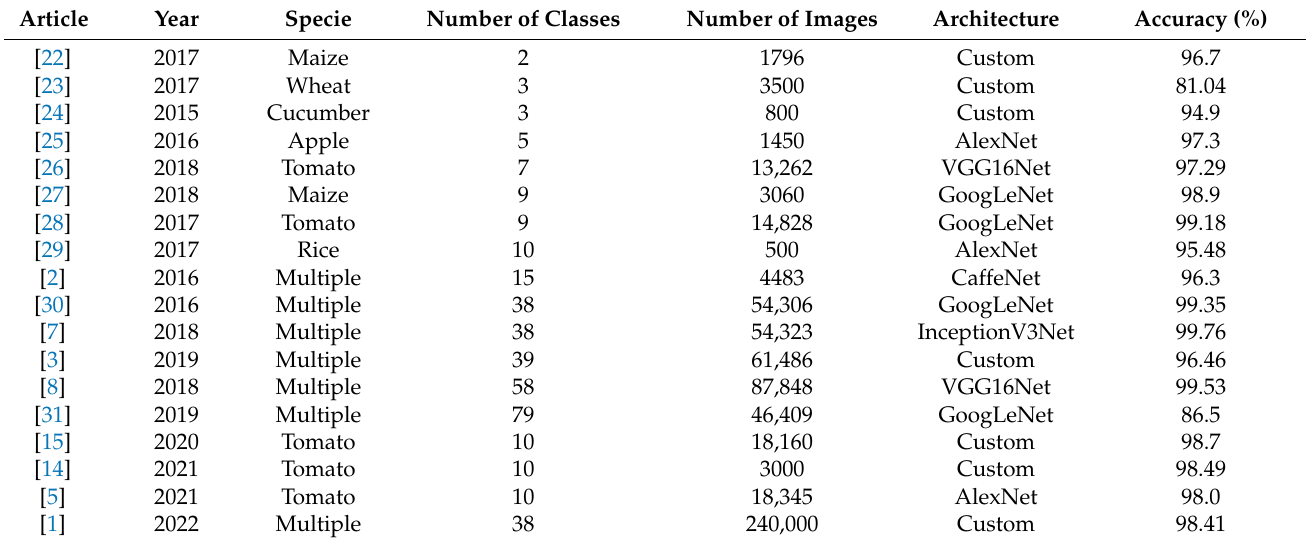
Table 1. Comparison of different DCNN